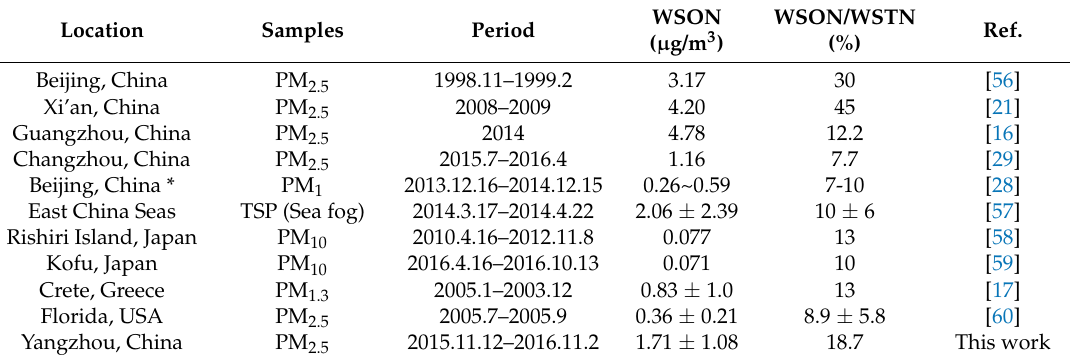
Table 1. Mass concentrations of water-soluble organic nitrogen (WSON) measured in different sites. Location